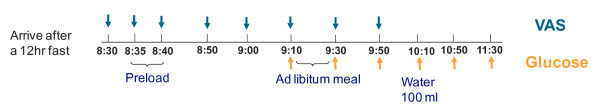
Test session timeline for Experiment 1. Subjects arrived at 8h15 in the morning and completed a baseline questionnaire to assess their state of well being and whether they were fasted on the day of the session. They then completed motivation-to-eat ratings. At 8h35 subjects consumed the preload within 5 min accompanied by 50 ml of water or just the water preload (250 ml), and rated their satiety feelings. Between 8h40 and 9h10, subjects continued to complete satiety ratings. At 9h10, subjects measured their plasma blood glucose after they completed the satiety ratings questions. Immediately after, they consumed an ad libitum meal. Once finished (9h30), the subjects completed 2 further sets of satiety questionnaires. They also measured their plasma glucose at different time-intervals.